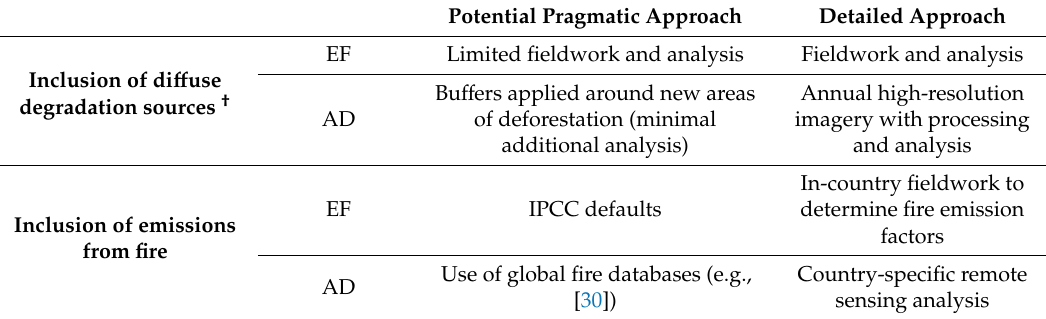
Table 3. Illustrative summary of key di ff erences (with implied costs) between a pragmatic and a detailed approach to accounting for activities, pools and gases that are often excluded from REDD + systems. (EF = emission factor; AD = activity